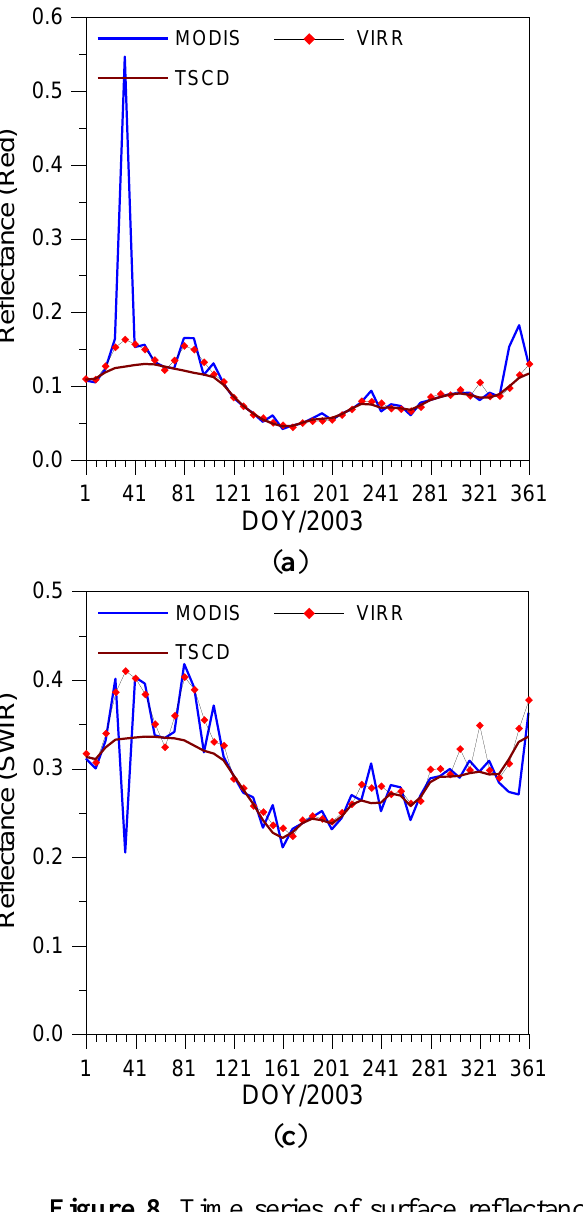
Figure 8. Time series of surface reflectance and NDVI from MOD09A1, the VIRR and TSCD algorithms for the center pixel of the Konza site in 2003. ( a ) surface reflectance in the red band; ( b ) surface reflectance in the NIR band; ( c ) surface reflectance in the SWIR band; ( d )